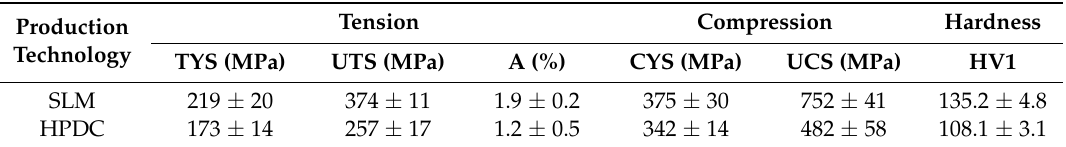
Figure 13. Representative stress-strain curves showing the comparison between the AlSi 9 Cu 3 Fe alloy prepared by SLM and conventional HPDC in mechanical properties: ( a ) Tension and ( b ) compression. Table 5. Measured mechanical properties of the SLM and HPDC AlSi 9 Cu 3 Fe alloy (TYS, tensile yield strength, UTS, ultimate tensile strength, A, elongation, CYS, compressive yield strength, UCS, ultimate compressive strength, and HV1, Vicker’s hardness with 1 kg load).